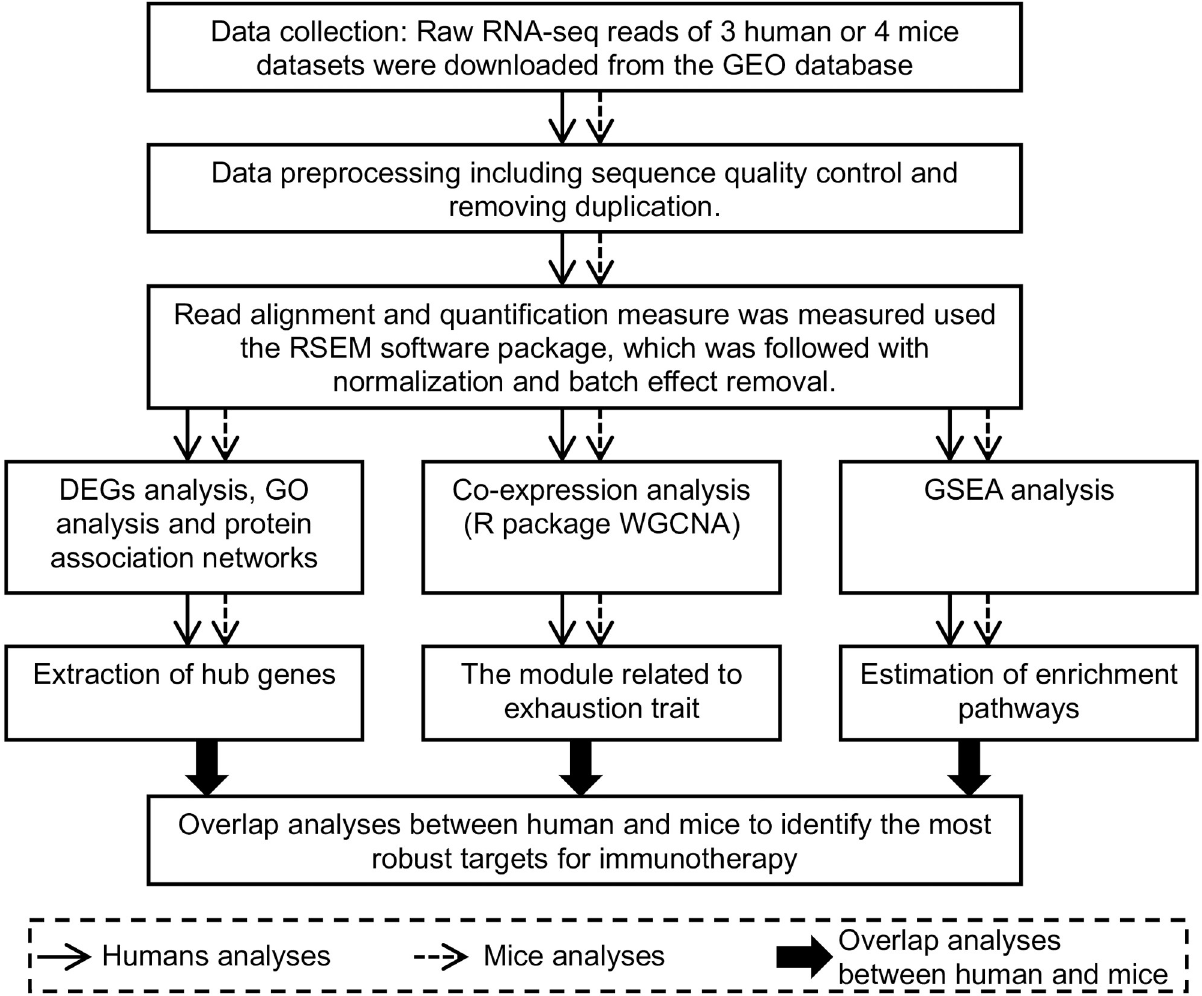
Fig 1. A schematic diagram of the workflow. GEO, Gene expression omnibus; RSEM, RNA-Seq by Expectation–Maximization; DEGs, Differentially expressed genes; GO, Gene ontology; WGCNA, Weighted correlation network analysis; GSEA, Gene set enrichment analysis.